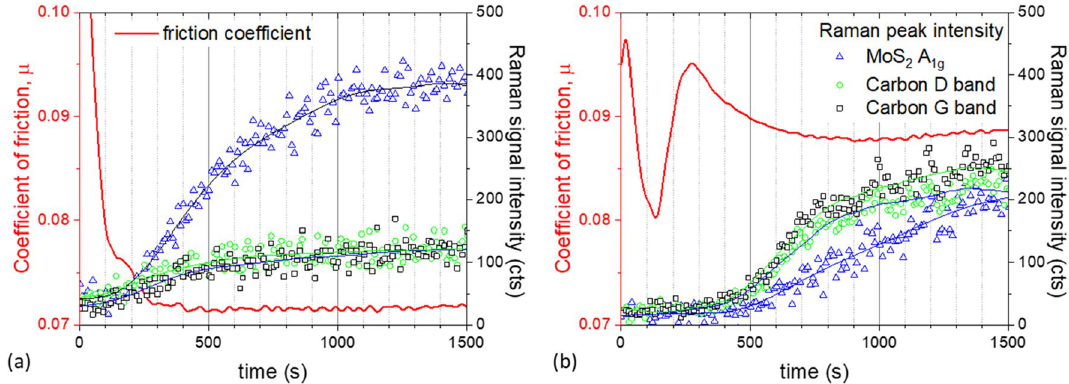
Figure 10. Friction curve and Raman signals measured at the side of the wear track at ( a ) 70 °C; and ( b ) 110